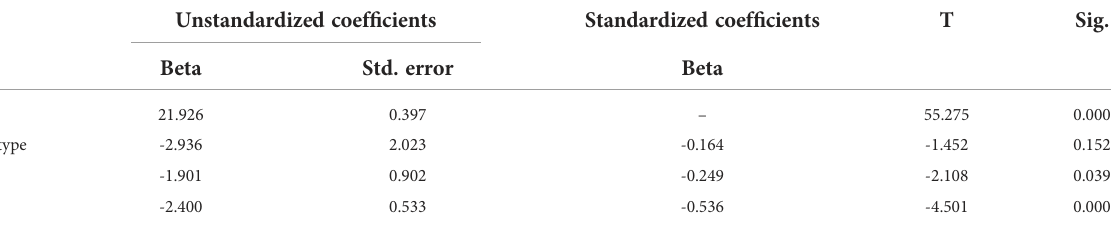
TABLE 4 Coef fi cients of Model BS.